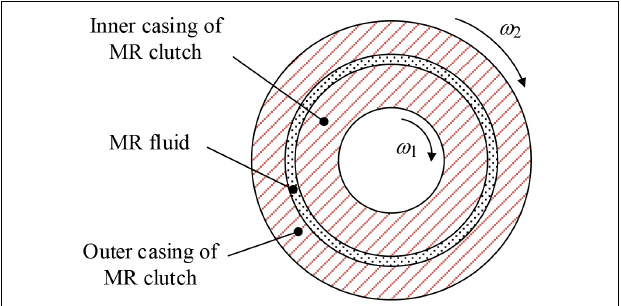
FIGURE 5 | Simplified model of the magnetorheological